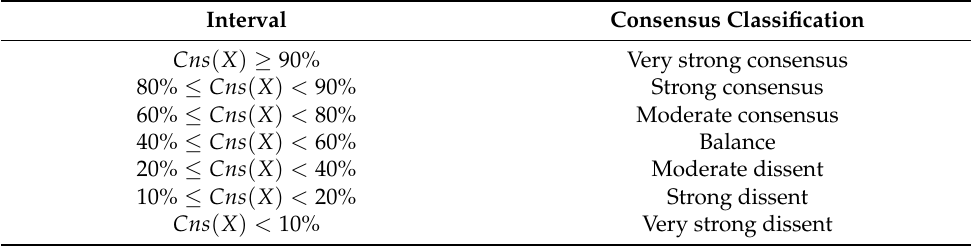
Table 8. Expert consensus